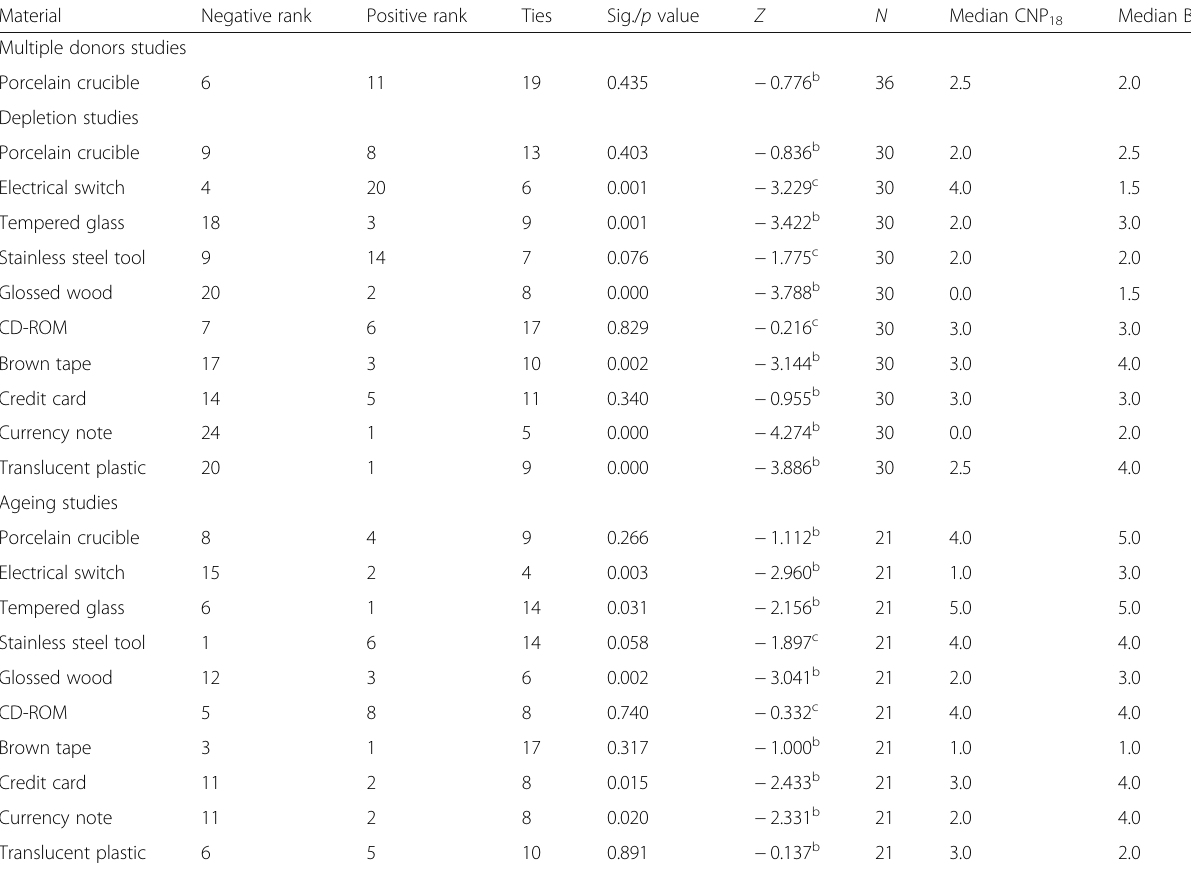
Table 2 Findings of Wilcoxon signed-rank test for scores of fingermarks retrieved from depletion and ageing studies upon each tested